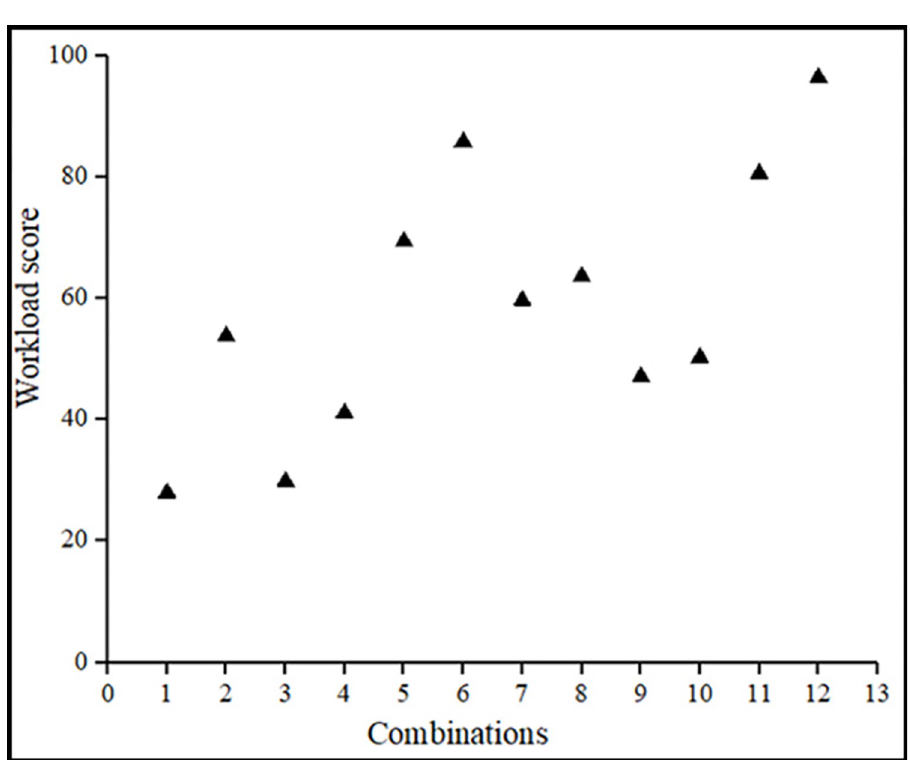
Fig 9. Driver’s subjective workload score under exit advance guide signs with different information combinations.